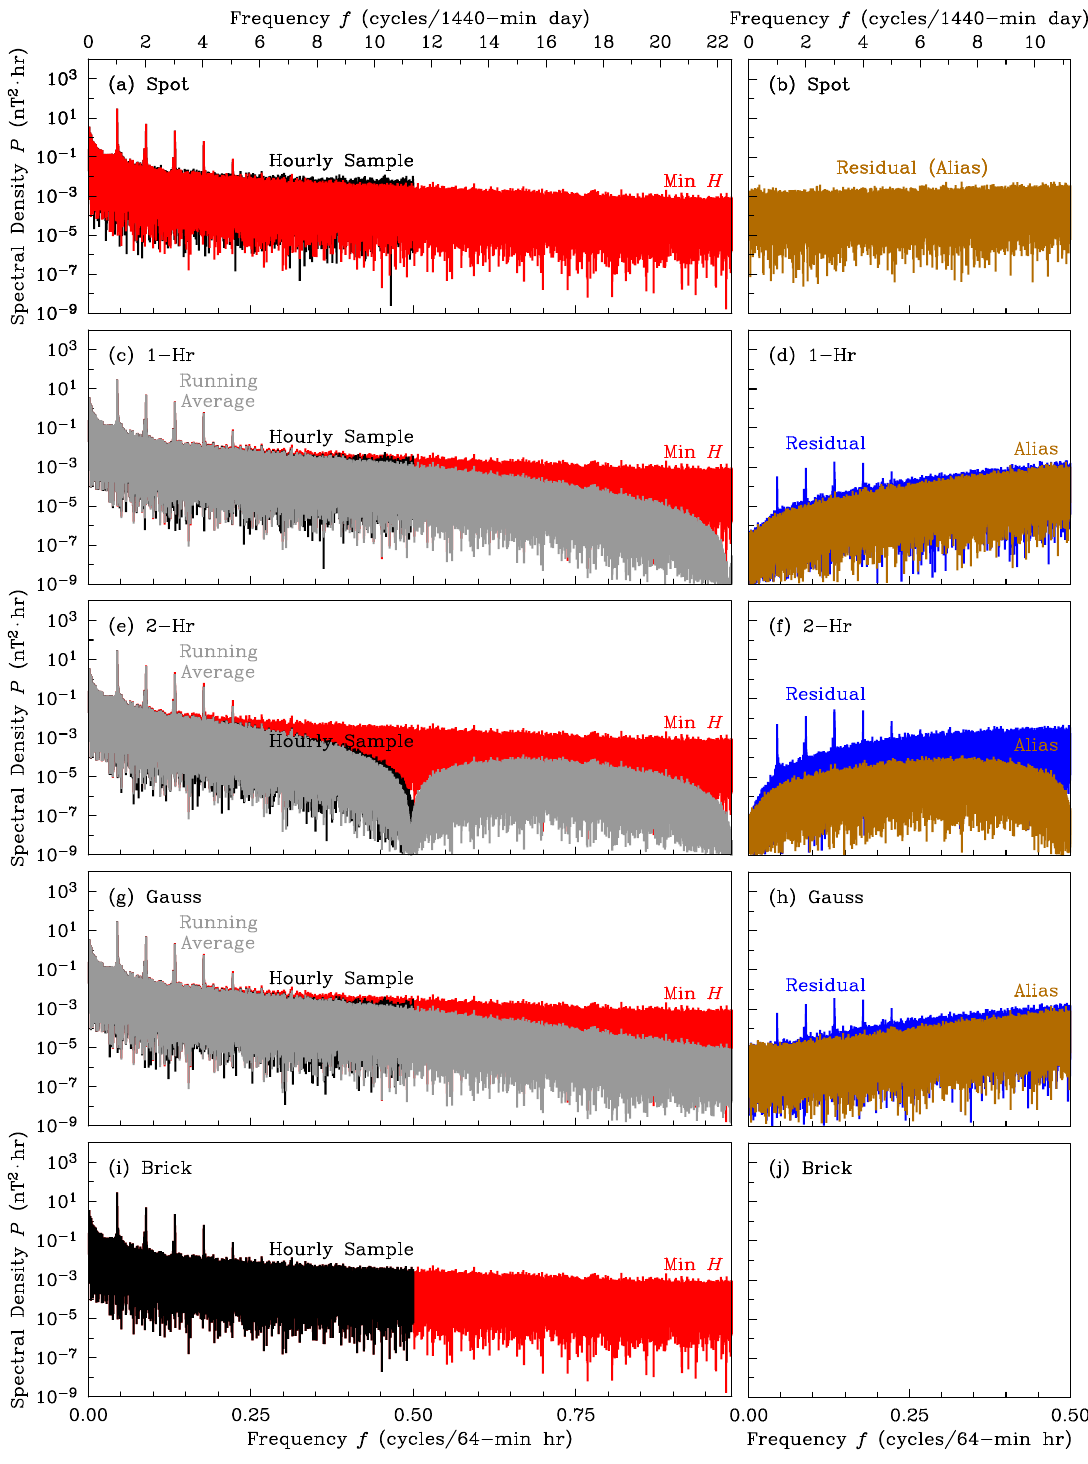
Fig. 3. Power spectral density P H (f ) as a function of frequency f , for CLF- H 1991.0–2009.0: (a, b) spot samples, (c, d) 1-h, (e, f) 2-h, (g, h) Gaussian, and (i, j) brick-wall average-samples. Shown are spectral densities of the source 1-min data P H (f ) (red), running averages P H a (f ) (gray), discrete hourly average-samples P H as (f ) (black), low-frequency residuals P L as (f ) (blue), and aliasing P S as (f ) (brown).